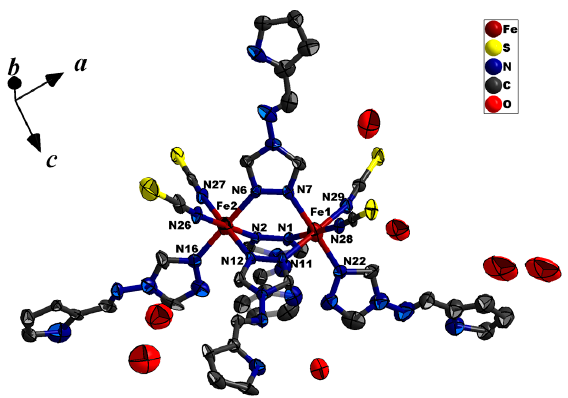
Figure 2. Thermal ellipsoid view of the binuclear molecular structure of C1 at 173 K, shown with 40% probability ellipsoids. All H atoms are omitted, and only selected atoms are labelled for clarity.